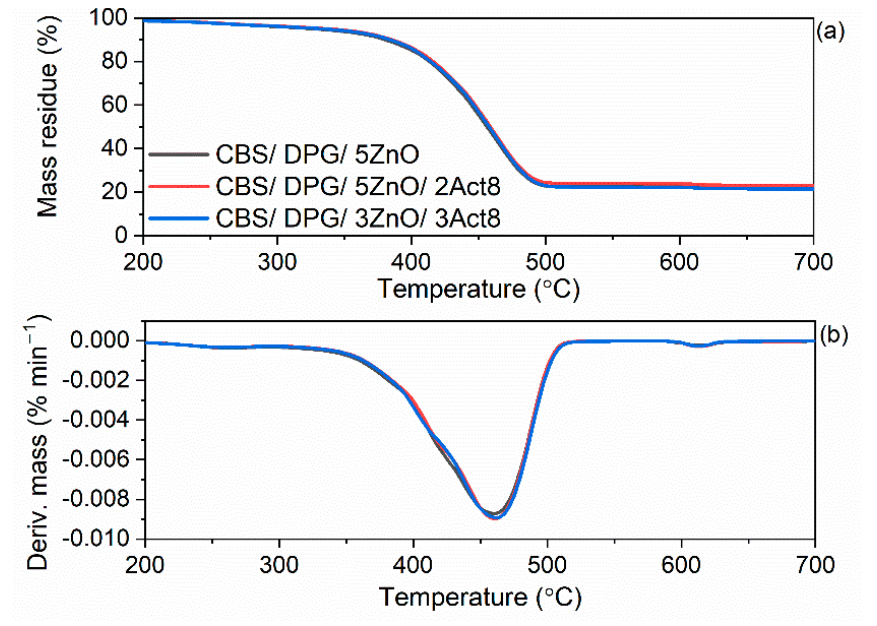
Figure 11. TG and DTG curves of SBR vulcanizates containing CBS and DPG: ( a ) TG curves; ( b ) DTG curves. Table 7. Thermal stability of SBR vulcanizates measured by thermogravimetry (TG) (T 5% , onset tem- perature of thermal decomposition; T DTG , DTG peak temperature; ∆ m, total mass loss during ther-